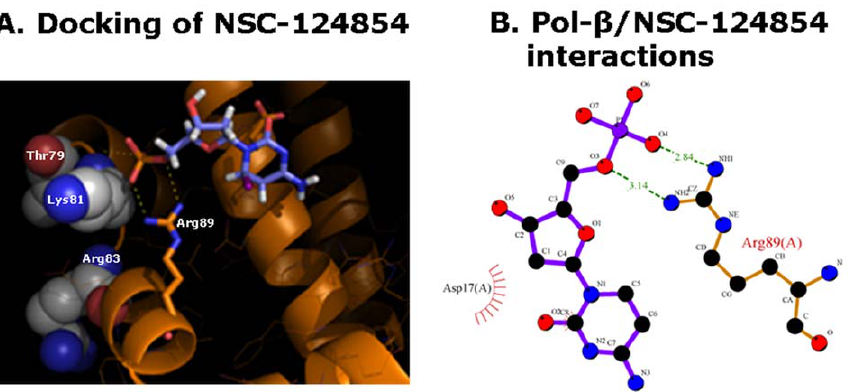
Figure 1. NSC-124854 complex with the simulated structure of Pol- b . Panel A shows the predicted interaction of NSC-124854 based on the crystal structure of Pol- b . Pol- b is shown in gold and side-chains predicted to form contacts with NSC-124854, Asp17 and Arg89, are depicted with gold for carbon, blue for nitrogen and red for oxygen. The APC binding pocket residues, Thr79, Lys81, Arg83 of Pol- b are shown as spheres colored gray for carbon, blue for nitrogen and red for oxygen. Polar contacts are depicted as yellow dashed lines between NSC-124854 and Pol- b residues Lys81 and Arg89. The figure was made with PyMol. Panel B depicts Pol- b -ligand interactions predicted based on the posed molecular docking orientation of NSC-124854. Interactions mediated by hydrogen bonds (green) and by hydrophobic (gray) contacts are shown. NSC-124854 and Pol- b are shown in black for carbon, blue for nitrogen and red for oxygen. Inter-atomic bonds of NSC-124854 are shown in magenta. Inter-atomic bonds of Pol- b are shown in gold. Hydrogen bonds are indicated by dashed lines between the atoms involved, while hydrophobic contacts are represented by an arc with spokes radiating towards the NSC-124854 atoms they contact. The contacted Pol- b atoms are shown with spokes radiating back. The figure was made with HBPLUS and